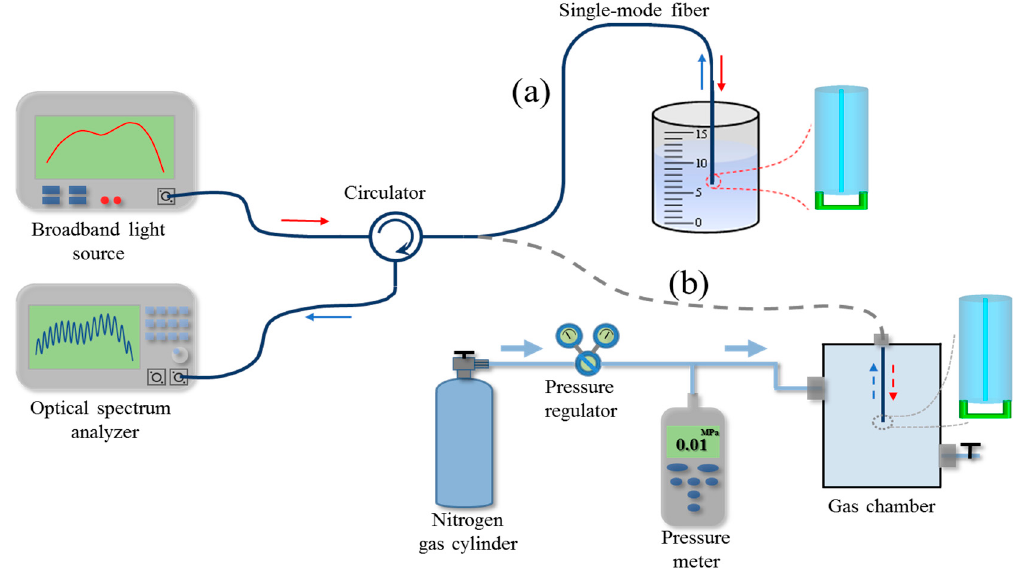
Figure 4. Schematic of the experimental setup for testing the optical fiber-tip sensors. ( a ) Refractive index sensing; ( b ) gas-pressure sensing.